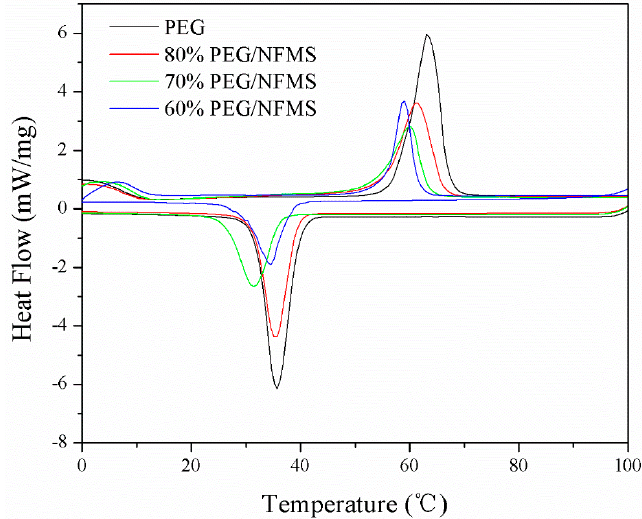
Figure 6. Differential scanning calorimetry (DSC) curves of PEG and PEG/NFMS at different concentrations.